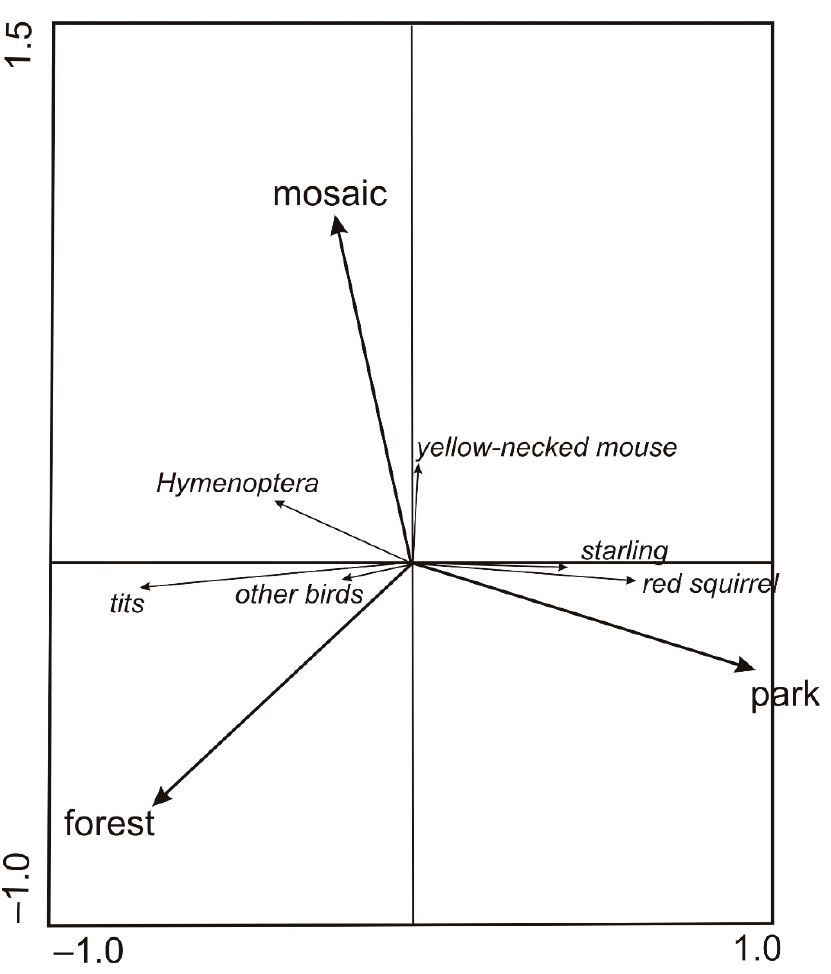
Figure 1. Biplot from redundancy analysis (RDA) showing the influence of the habitat (continuous forest, habitat mosaic, urban park) on the variability in species of animals building their nests in the boxes dedicated to the red squirrel in central Poland in the years 2014–2020.